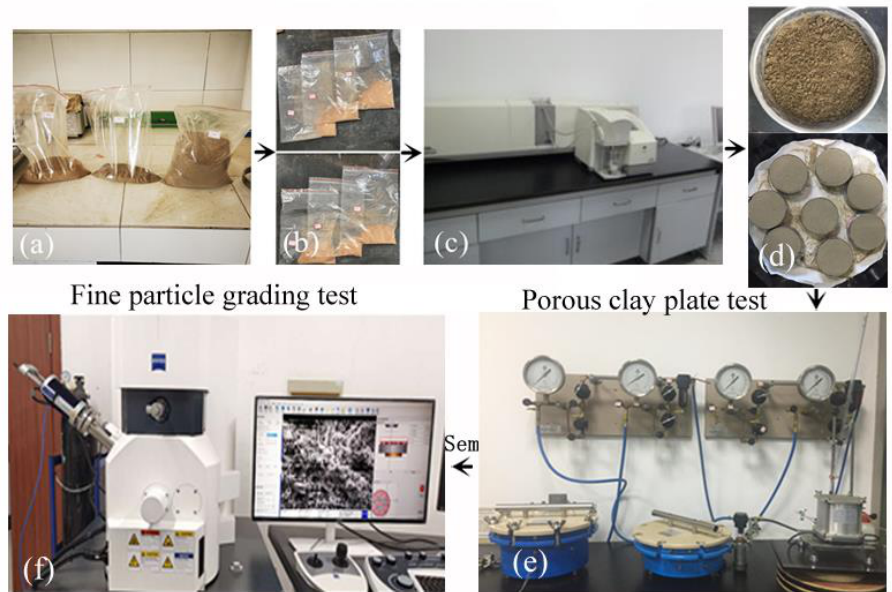
Figure 5. Soil property test. ( a ) Sieving soil samples; ( b ) sub packaging of soil particles; ( c ) laser particle analysis test; ( d ) remodeling soil preparation; ( e ) measuring the relationship between permeability coefficient and matric suction; ( f ) scanning soil using electron microscope.